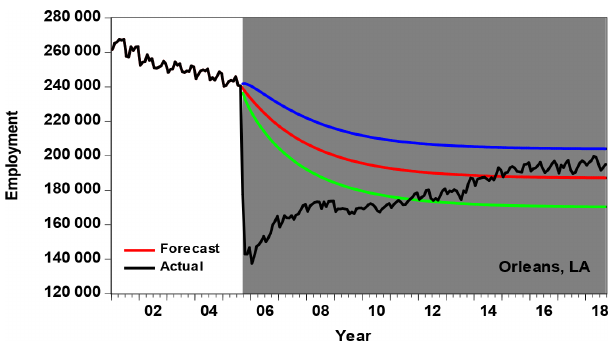
Figure 5. Permanent effects of Hurricane Katrina in Orleans